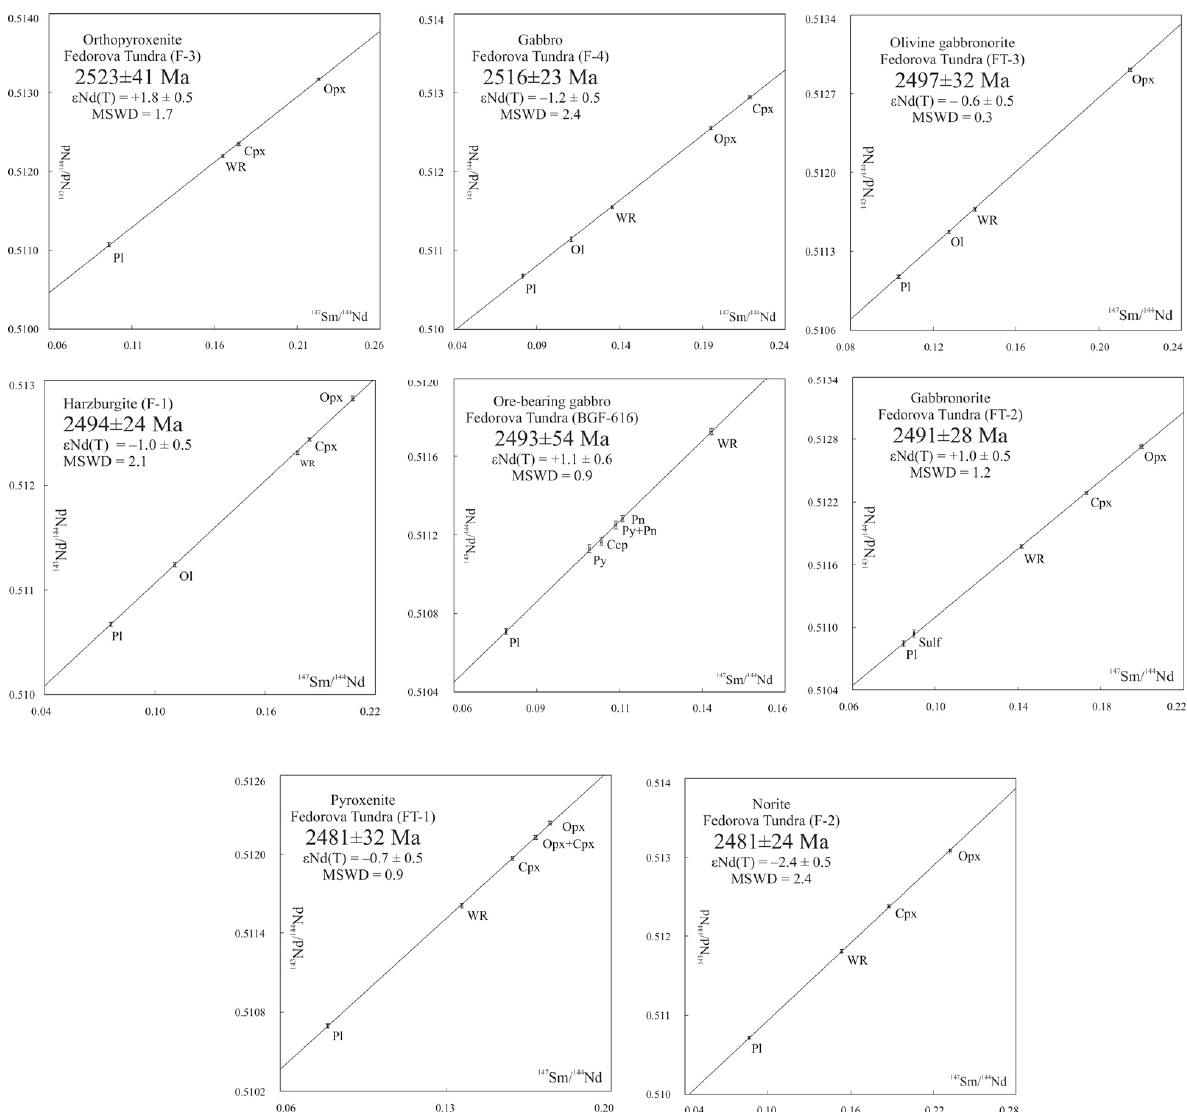
Figure 6. Mineral Sm-Nd isochrones for rocks of the Fedorova Tundra deposit.